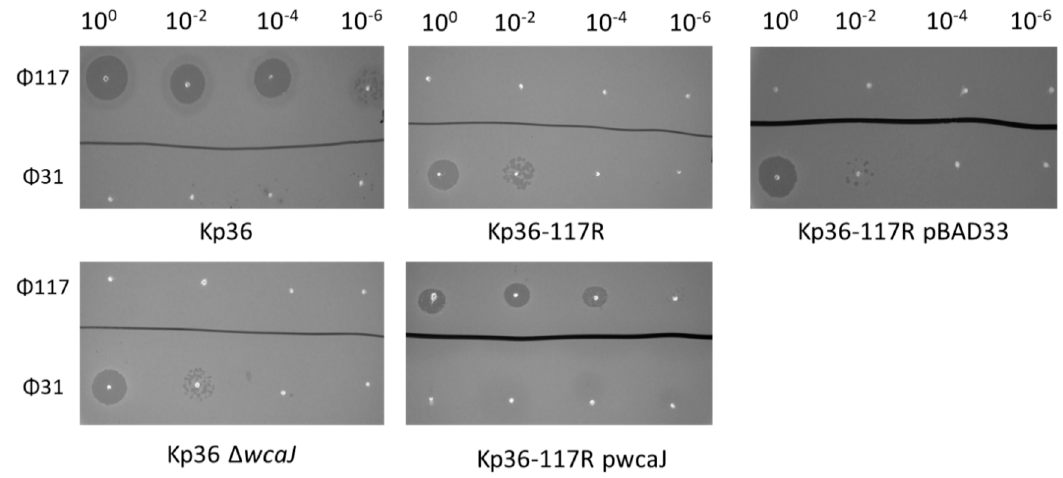
Figure 4. Spot test assay of phage 117 and phage 31 on the parental K. pneumoniae strain Kp36 and its derived mutants (Kp36-117R, Kp36 Δ wcaJ , Kp36 pBAD, and Kp36-117R pwcaJ).